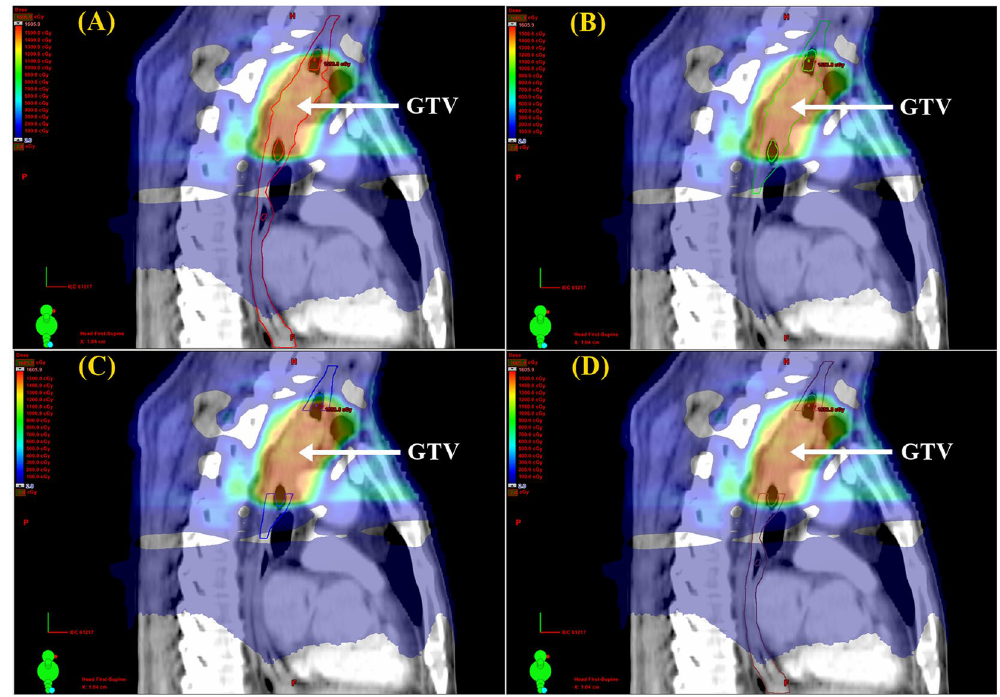
Figure 2. Esophageal dose variation for four DEs. Color wash displayed the dose difference between the SIB- IMRT and SD-IMRT dosing strategies from one representative case. ( A ) Dose for ESO whole (red line), ( B) dose for ESO infield (green line), ( C ) dose for ESO infield-tumor (blue line), ( D ) dose for ESO whole-tumor (brown line). ESO whole = the entire esophagus, including the tumor; ESO infield = the portion of ESO whole within the treatment field; ESO infield-tumor = the portion of ESO infield excluding the tumor; ESO whole-tumor = the portion of ESO whole excluding the tumor. SIB-IMRT = intensity-modulated radiation therapy with simultaneous integrated boost; SD-IMRT = standard-dose intensity-modulated radiation